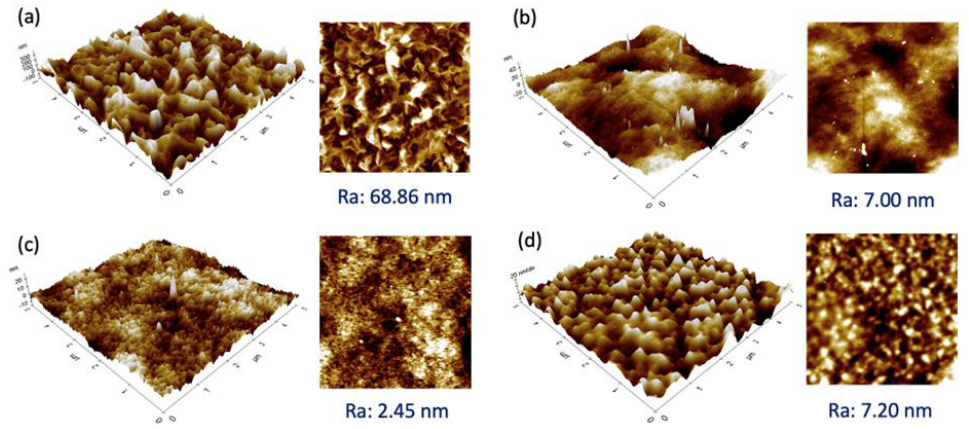
Figure 3. 3D (left) and 2D (right) AFM images of RO and NF membranes together with R a value, ( a ) SW30XLE, ( b ) BW30, ( c ) NF3, and ( d ) Duracid.